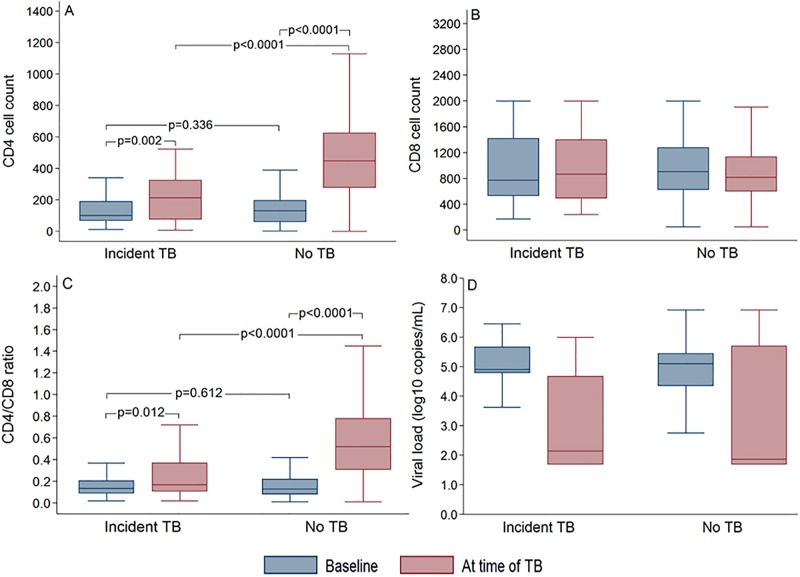
CD4 cell count (A), CD8 cell count (B), CD4/CD8 ratio (C) and viral load levels (D) at time of TB in patients who developed incident TB vs. those who remained free from TB.Data are presented as medians (IQR).